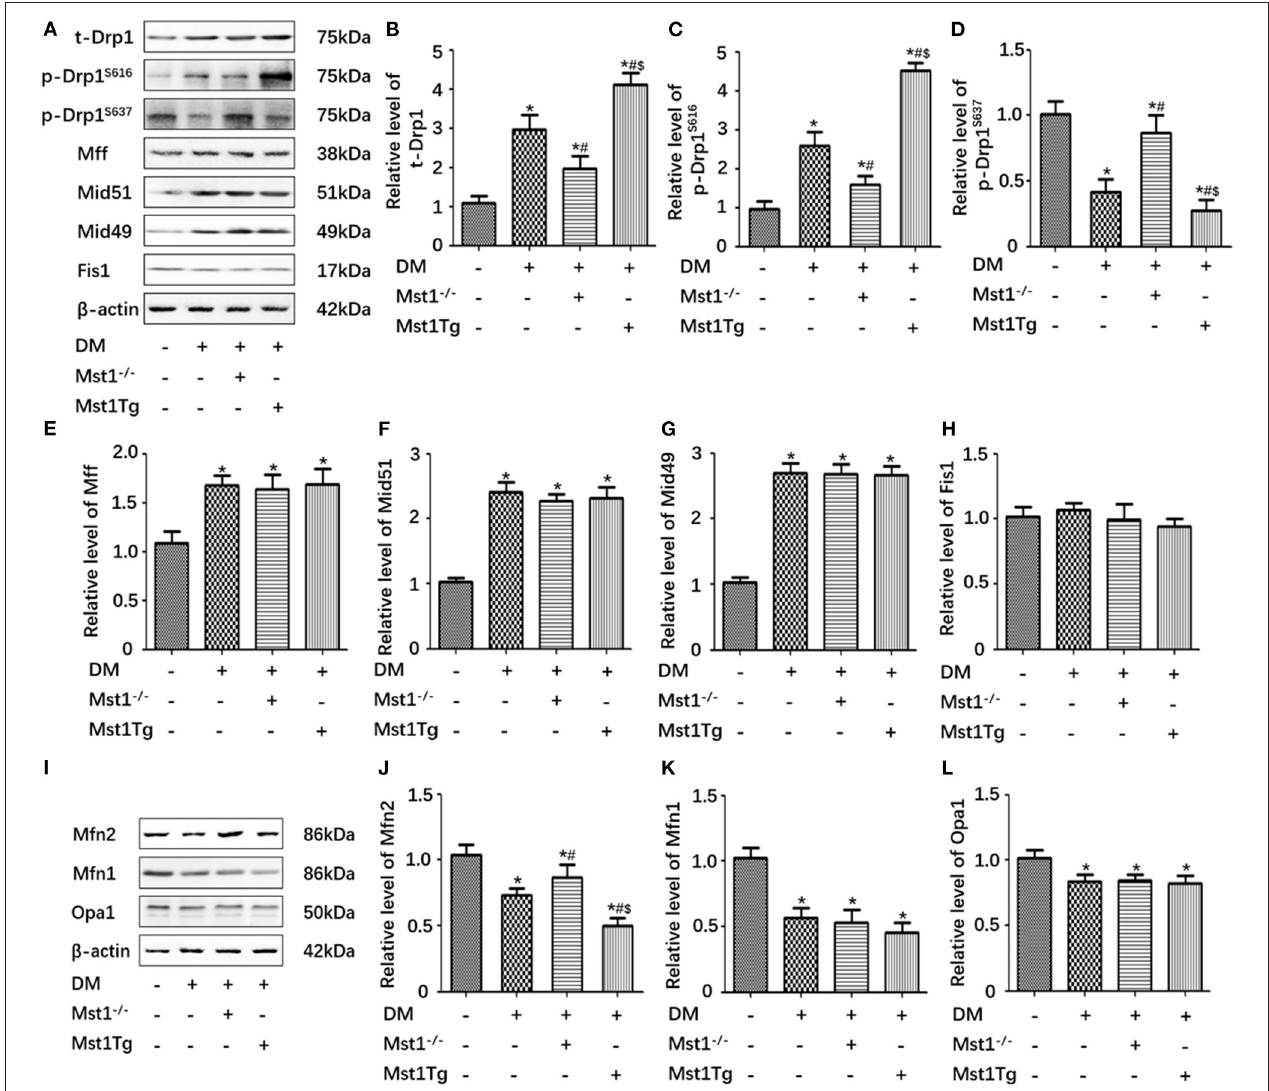
FIGURE 3 | Mst1 knockout decreases Drp1 expression, inhibits Drp1 S616 phosphorylation and promotes Drp1 S637 phosphorylation in DCM. (A) Protein expression with representative gel blots of t-Drp1, p-Drp1 S616 , p-Drp1 S637 , Mff, Mid51, Mid49, Fis1, and β -actin (loading control for Drp1, Mff, Mid51, Mid49 and Fis1). (B) Relative level of t-Drp1. (C) Relative level of p-Drp1 S616 . (D) Relative level of p-Drp1 S637 . (E) Relative level of Mff. (F) Relative level of Mid51. (G) Relative level of Mid49. (H) Relative level of Fis1. (I) Protein expression with representative gel blots of Mfn2, Mfn1, Opa1, and β -actin (loading control for Mfn2, Mfn1, Opa1). (J) Relative level of Mfn2. (K) Relative level of Mfn1. (L) Relative level of Opa1. The columns and error bars represent the means and SEM. * P < 0.05 vs. WT; # P < 0.05 vs. DM; and $ P < 0.05 vs. HG + Mst1 − / −